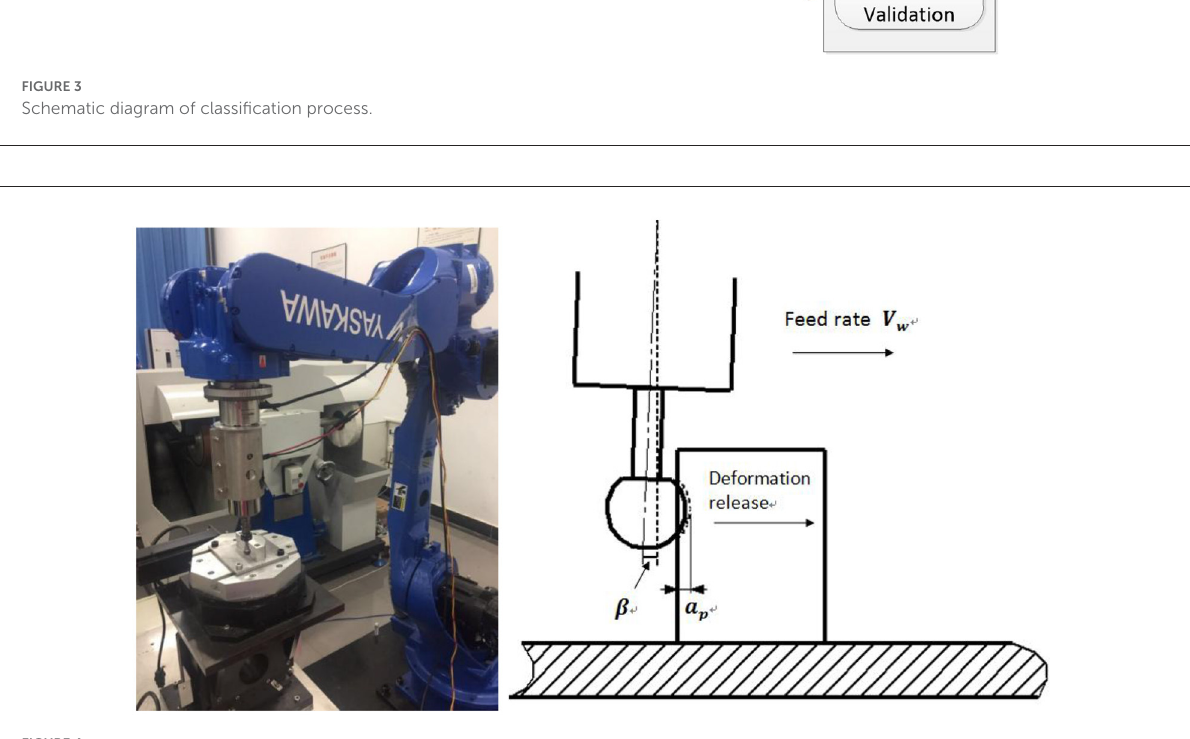
FIGURE4 Robotic grinding